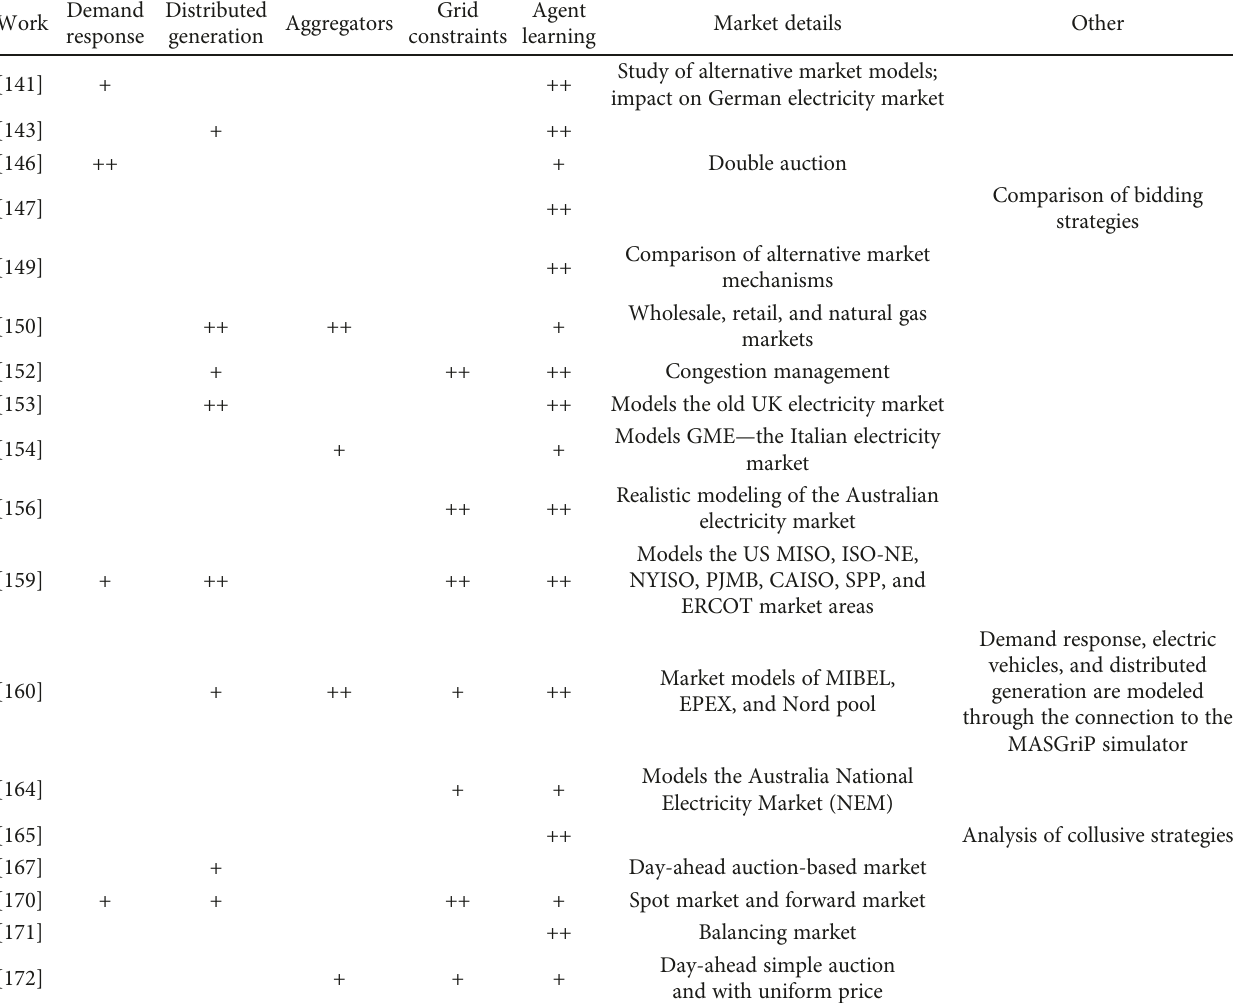
Table 9: Comparison of the main characteristics of some of the most relevant electricity market simulators. Demand Distributed Work response generation